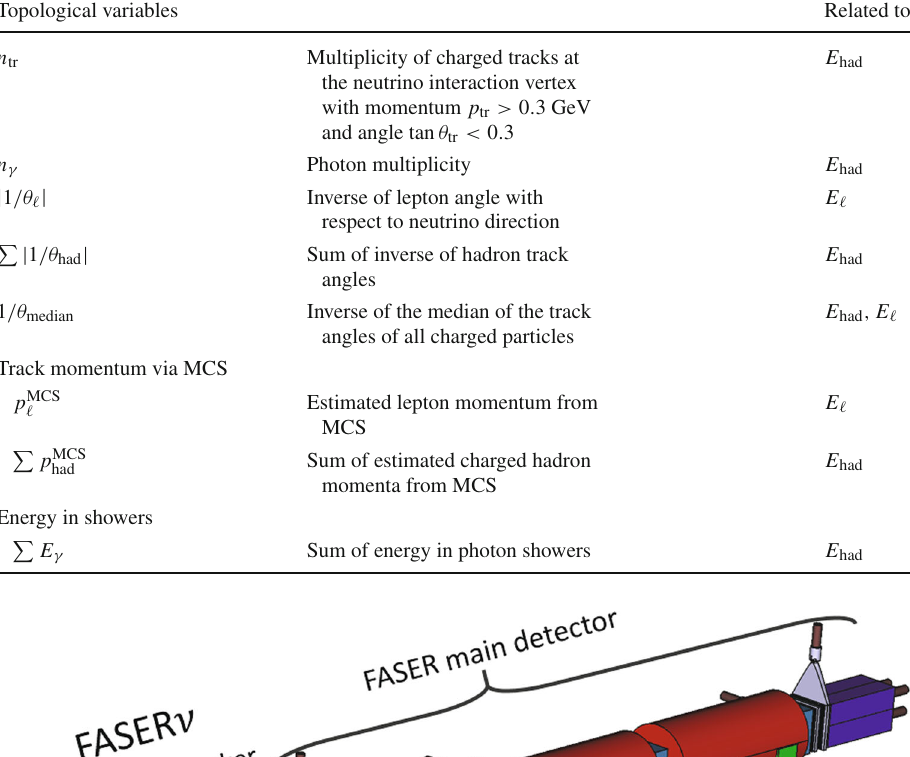
Fig. 12 Plan of the detector upgrade to couple FASER ν to the FASER main detector. The components include the FASER ν emulsion detector (black), scintillators (gray), tracking layers (blue), magnets (red), and electromagnetic calorimeter